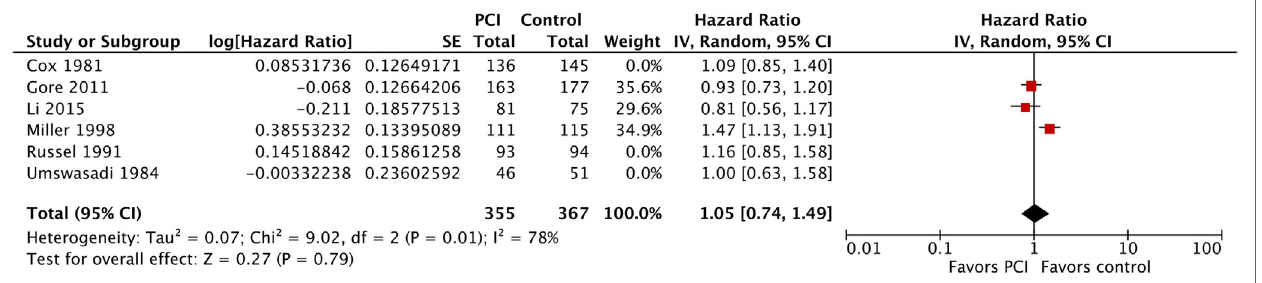
FigURe 8 | Sensitivity analysis: effect of PCI on overall survival in 722 patients with stage III non-small-cell lung cancer from three trials published after 1995. Abbreviations: PCI, prophylactic cranial irradiation; CI, confidence